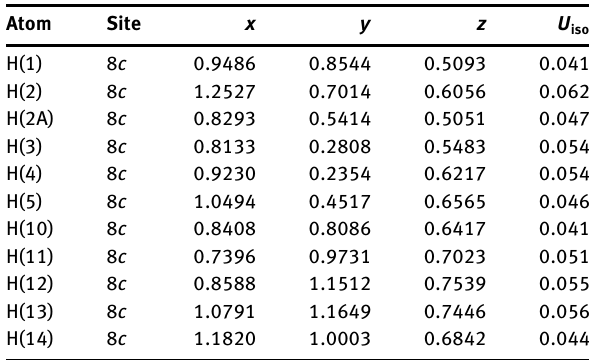
Table 2: Fractional atomic coordinates and isotropic or equivalent isotropic displacement parameters (Å 2